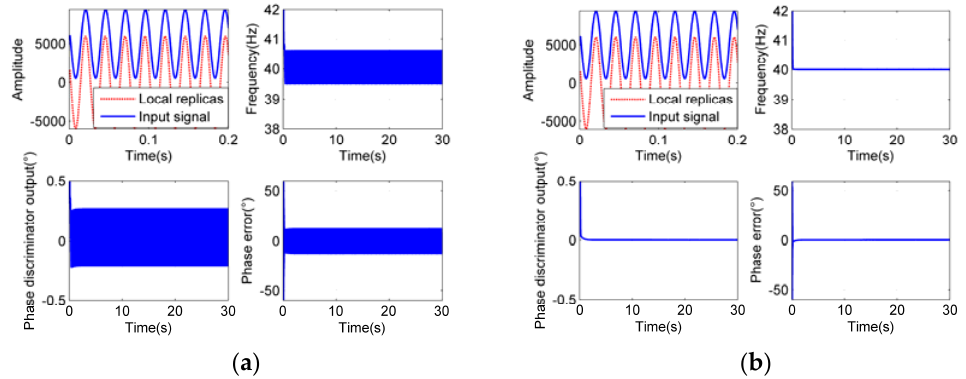
Figure 15. Tracking process at rotational speed of 40 Hz, B FLL = 0.3 Hz, B PLL = 0.5 Hz, ξ = 0.5. ( a ) is the tracking result at T roll = 13 ms, ( b ) is at T roll = 25 ms.